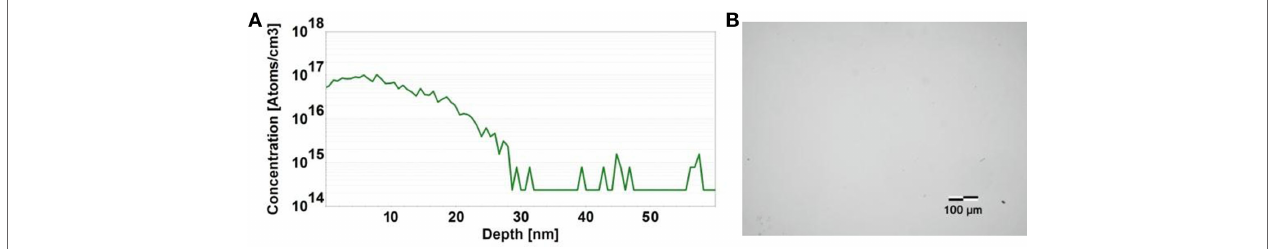
FIGURE 5 | Secondary ion mass spectroscopy profile of a phosphorus-doped diamond film grown on a (100) oriented surface (A) and the corresponding surface morphology acquired via optical microscopy indicating no detectable growth defect formation (B) .